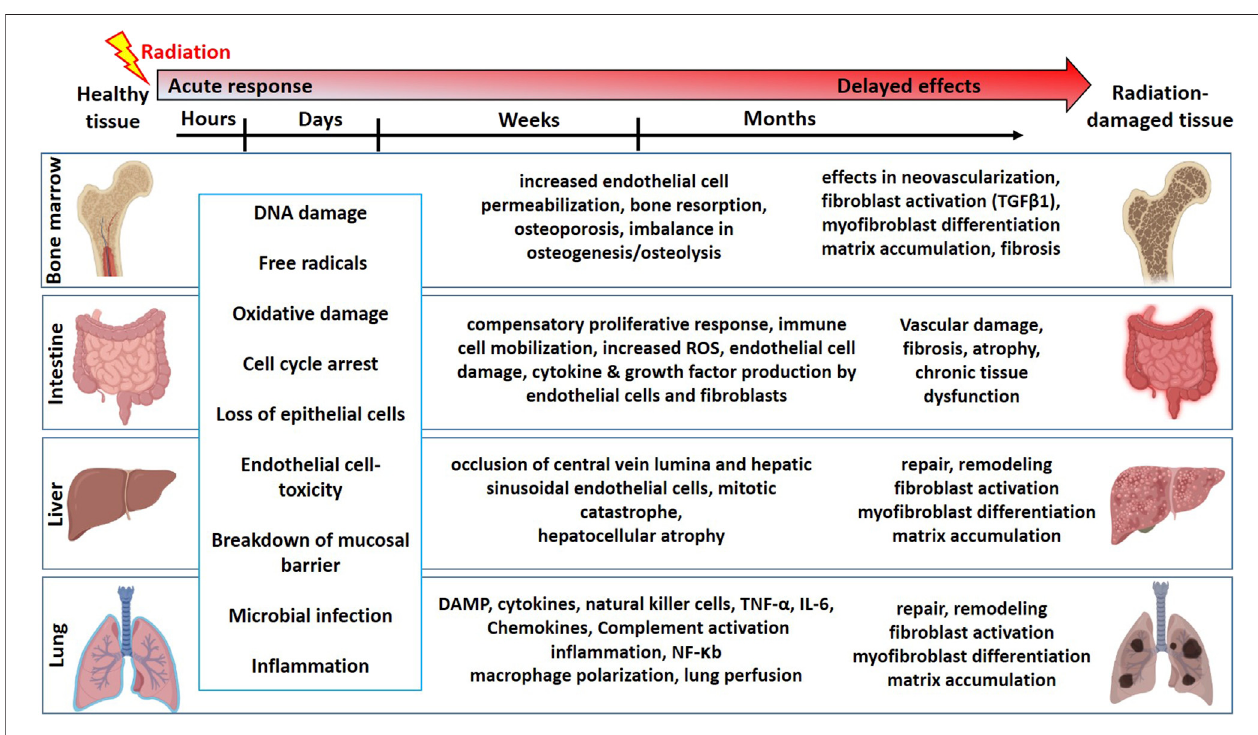
Frontiers in Pharmacology |